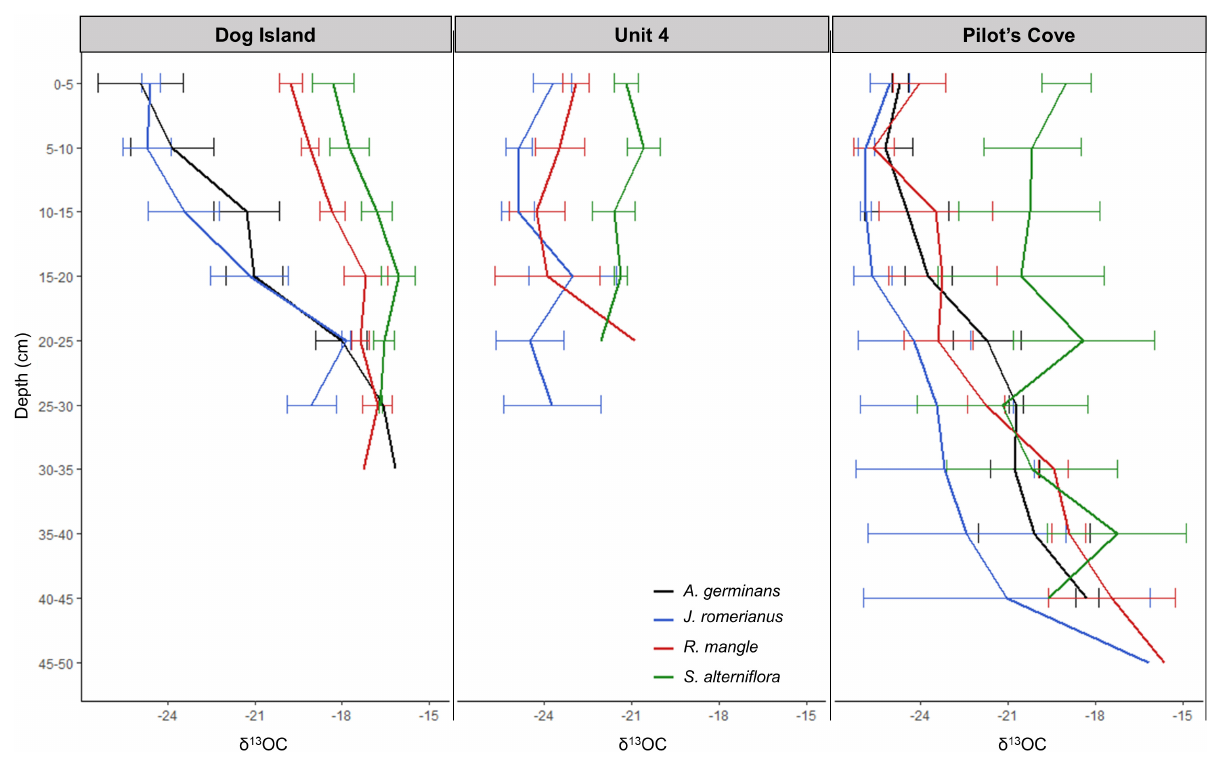
FIGURE 3 | Means and standard error of δ 13 OC (